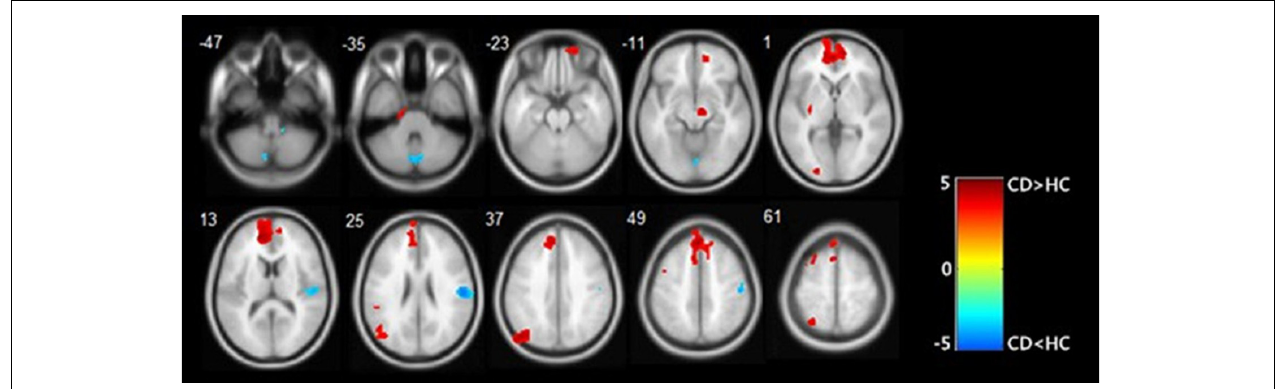
FIGURE 2 | Results of VBM analysis presented at p < 0.001 and an extent threshold of 50 adjacent voxels. CD groups presented some regions with increased gray matter volume (in red) and some with decreased gray matter volume (in blue). Colors symbolize T scores (see color bar).